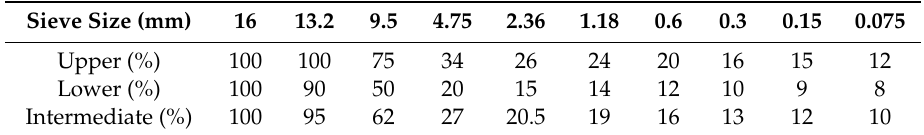
Table 2. Gradation of Aggregate Used for SMA-13 (According to the Chinese standard of JTG F40-2004 [44]).